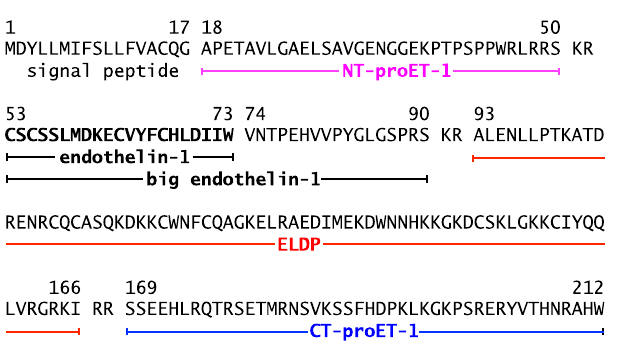
Figure 1. Amino acid sequence of preproendothelin-1 indicating the peptide products generated by processing at double basic